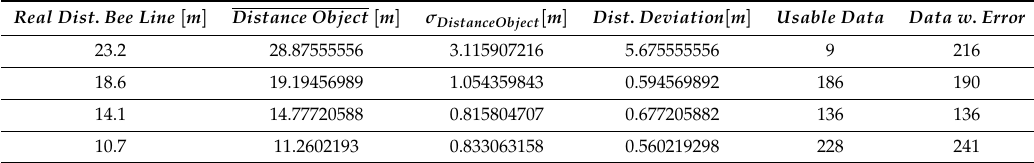
Table 1. Measurement results on the curved